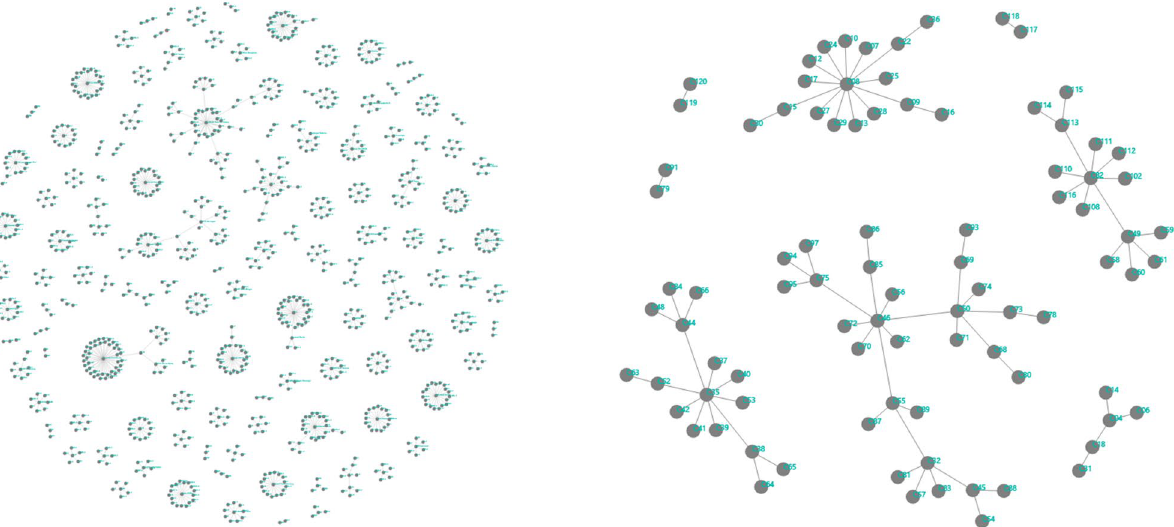
Figure 1. Networks of secondary infections based on local transmissions in Jakarta–Depok (left) and Batam (right)